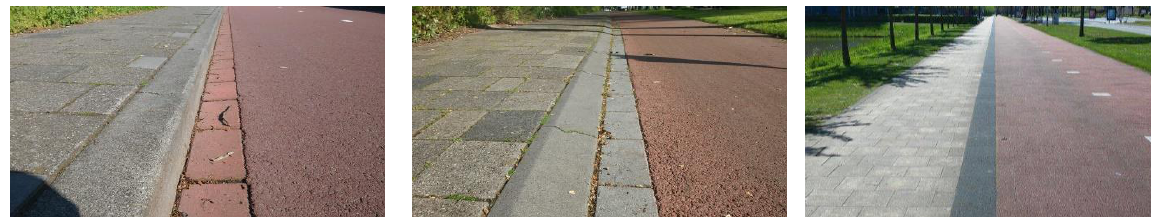
Figure 1. Kerb types applied in the Netherlands (From left to right: right angled kerbs, sloped kerbs, levelled